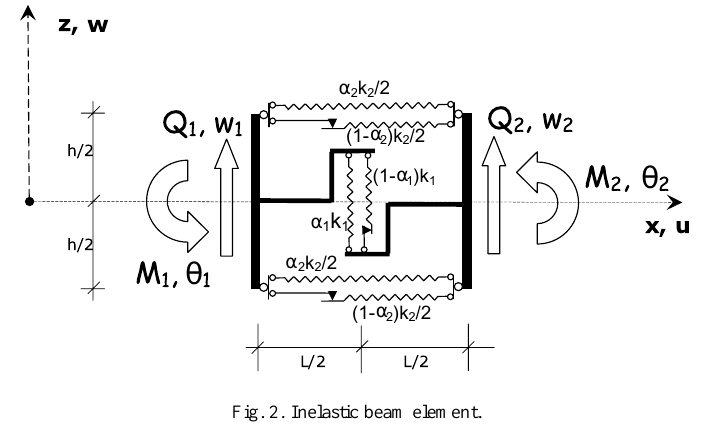
Fig. 2. Inelastic beam